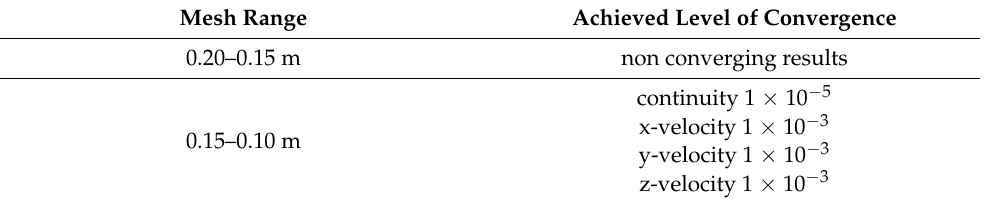
Table 1. Results for the mesh independent